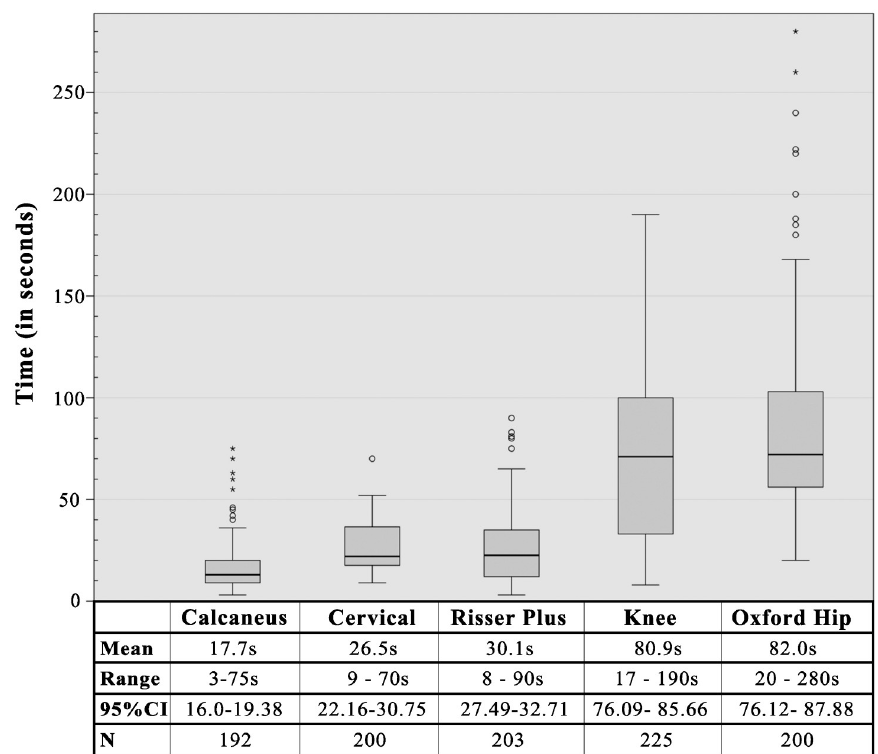
Fig 13. Timing data for each of the bone age